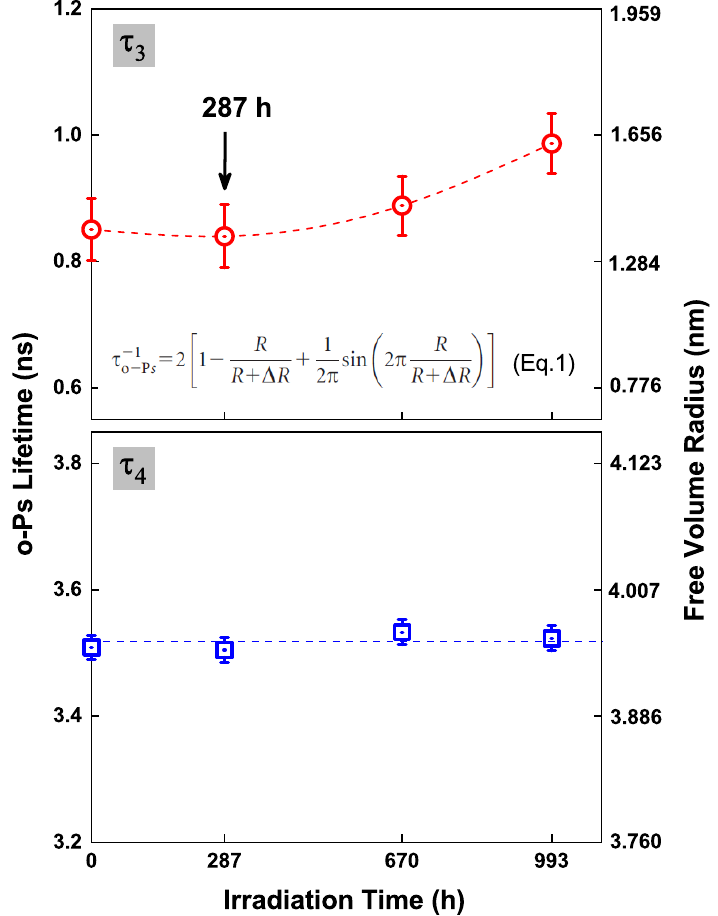
Figure 7. The o-Ps lifetimes ( τ 3 , τ 4 ) and the corresponding free volume sizes (according to Tao’s model [30]) in silicone rubbers after different durations of UVB